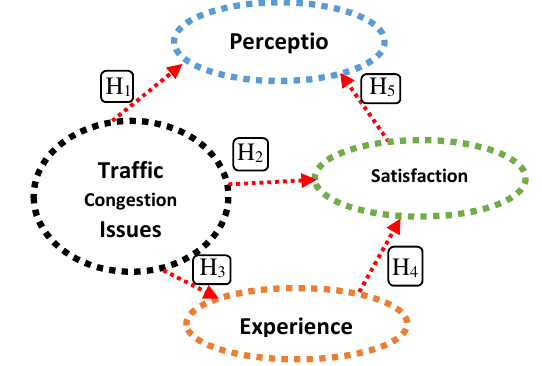
FIG. 1: TRAFFIC CONGESTION ISSUES PERCEPTIONS, EXPERIENCES & SATISFACTION: A CONCEPTUAL